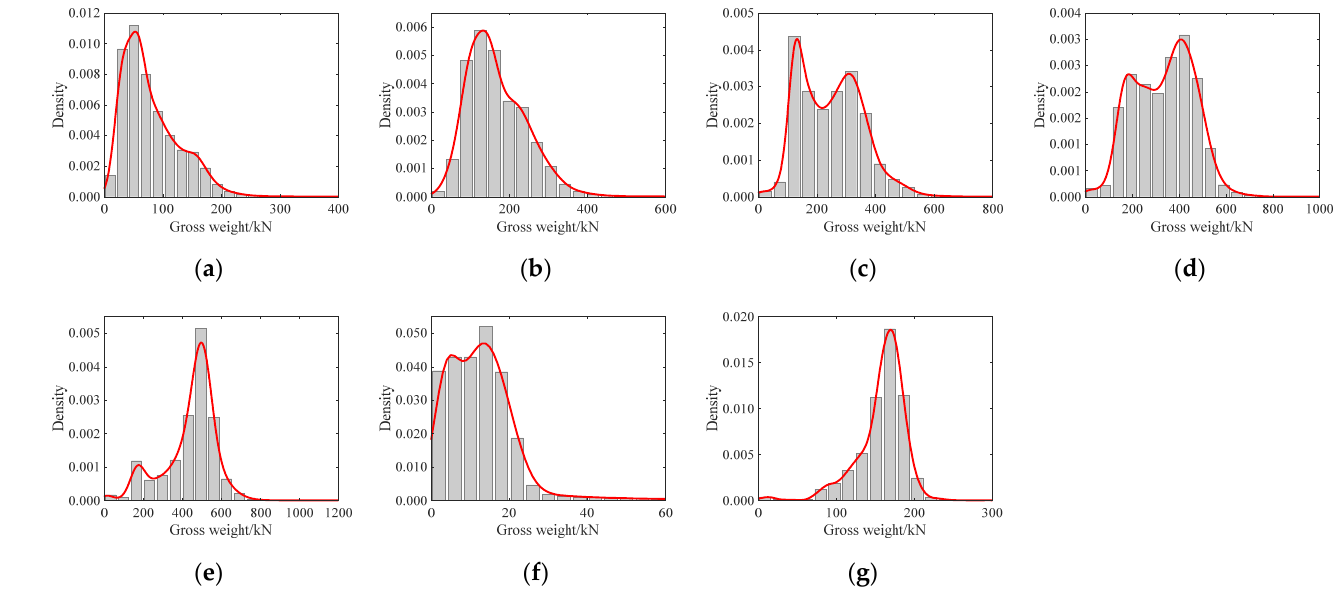
Figure 4. Probability distribution of gross weight for each type of vehicle. ( a ) Type A. ( b ) Type B. ( c ) Type C. ( d ) Type D. ( e ) Type E. ( f ) Type F. ( g ) Type G.